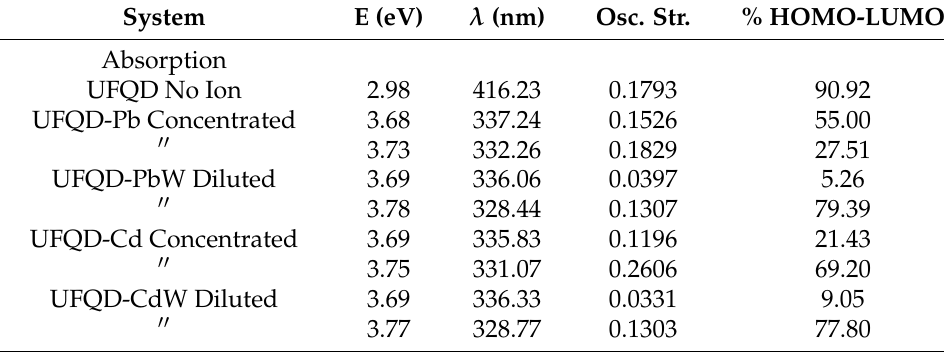
Table 1. Energy, wavelength, oscillator strengths, and percent contributions of HOMO-LUMO transition of the calculated absorption and emission spectra of graphene-ion systems. The letter W refers to model with explicit waters